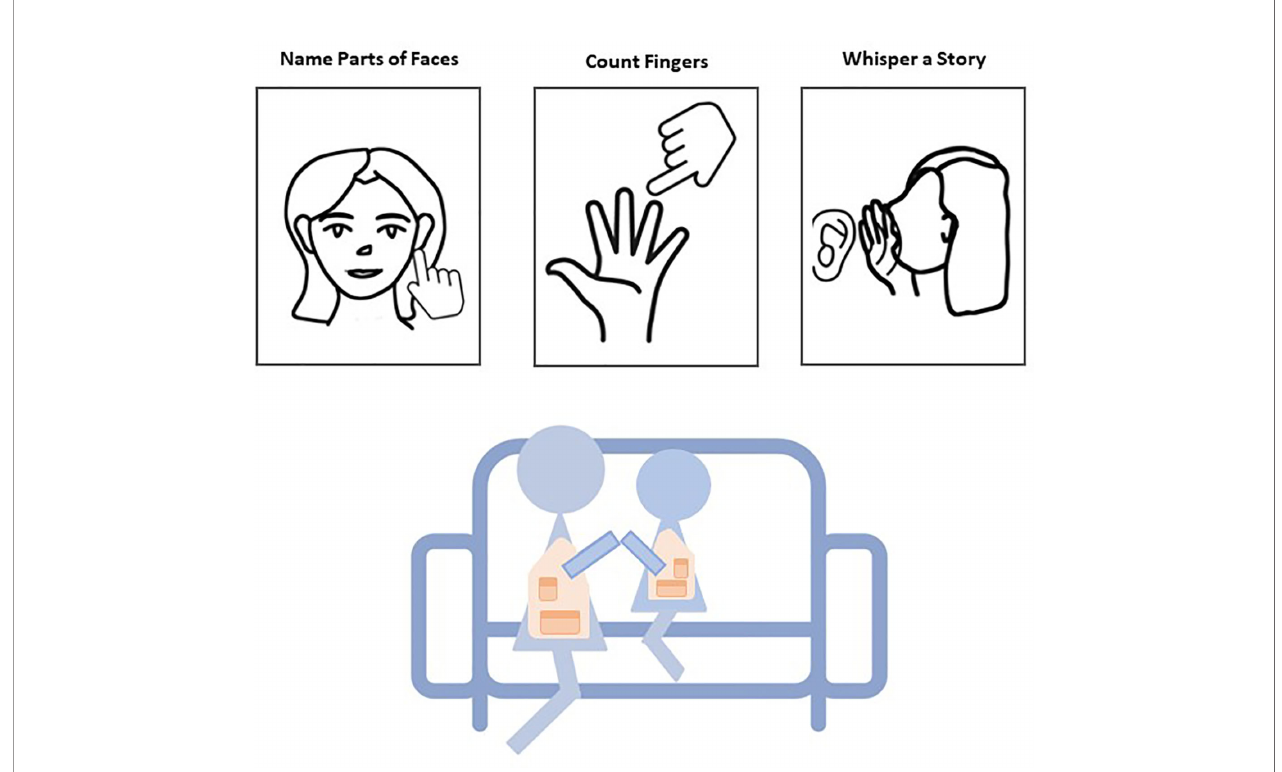
FIGURE 3 | Schematic of the Social Engagement Task is presented. Children and parents engage in three fi xed-interval activities that are presented on a screen while cardiac physiology is